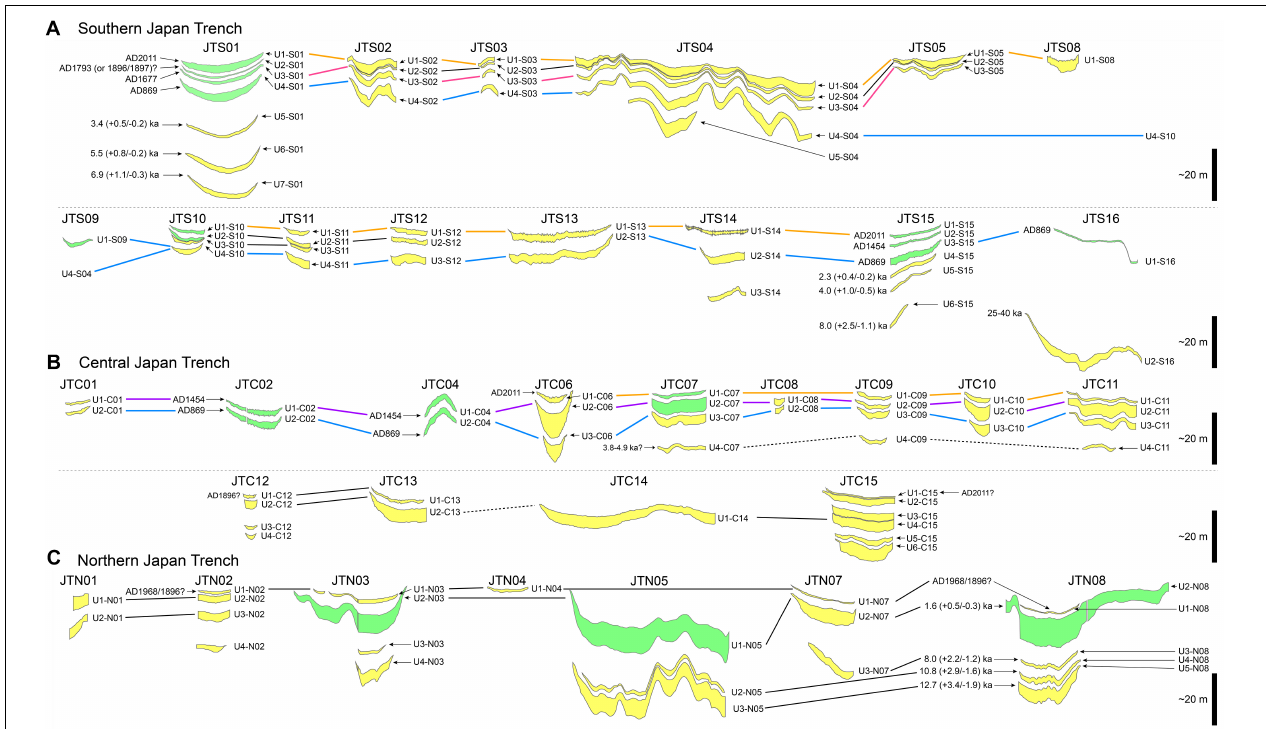
FIGURE 7 | Correlation of identified event deposit bodies between neighboring trench-fill basins in (A) the southern Japan Trench, (B) the central Japan Trench, and (C) the northern Japan Trench. The solid lines connecting individual identified event units between different basins indicate that the correlation is supported either by both image interpretation and DTW or evidence from cores, while the dash lines connecting individual identified event units indicate the correlation is expected from either image interpretation or